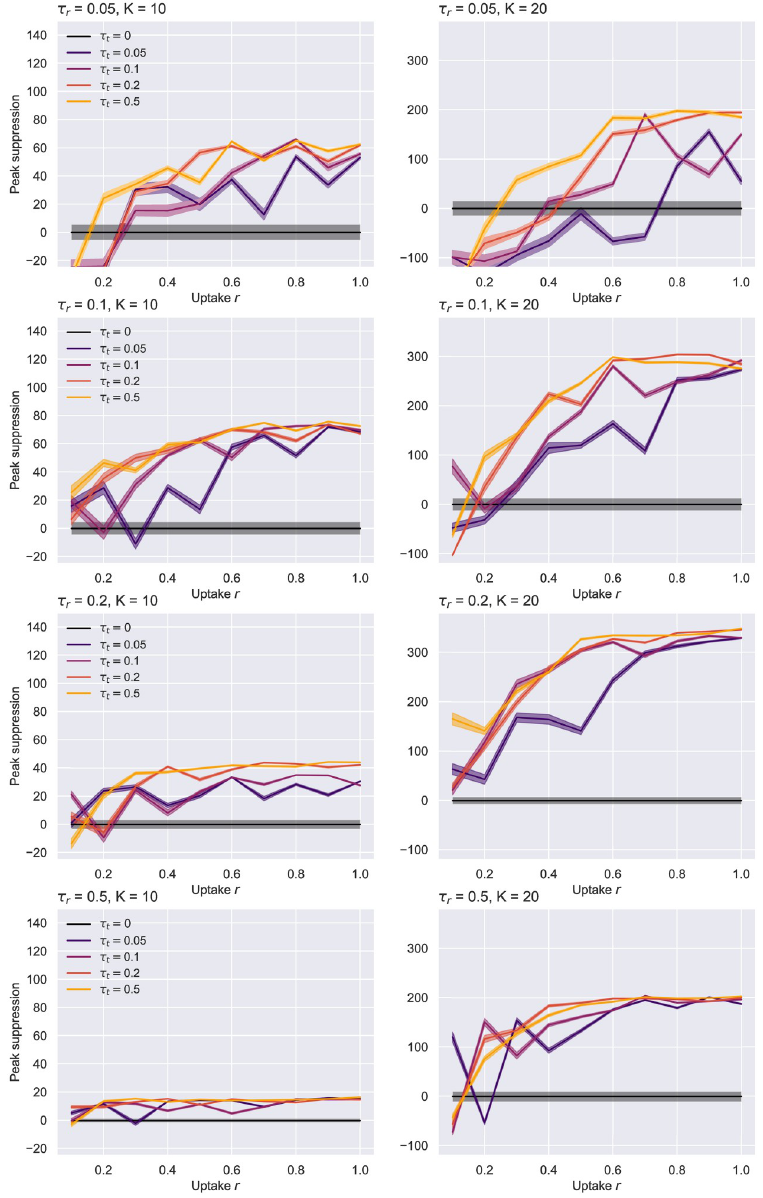
Fig 9. ER network—Uptake rate r against peak suppression. Suppression is difference in peak to no tracing, i.e. τ t = 0. N = 1000, p = 0.2, η = .001. K = 10 given on the left, K = 20 on the right. The case with no contact tracing ( τ a colored in black. All lines were plotted with the 95% confidence intervals resulted from 750 runs.